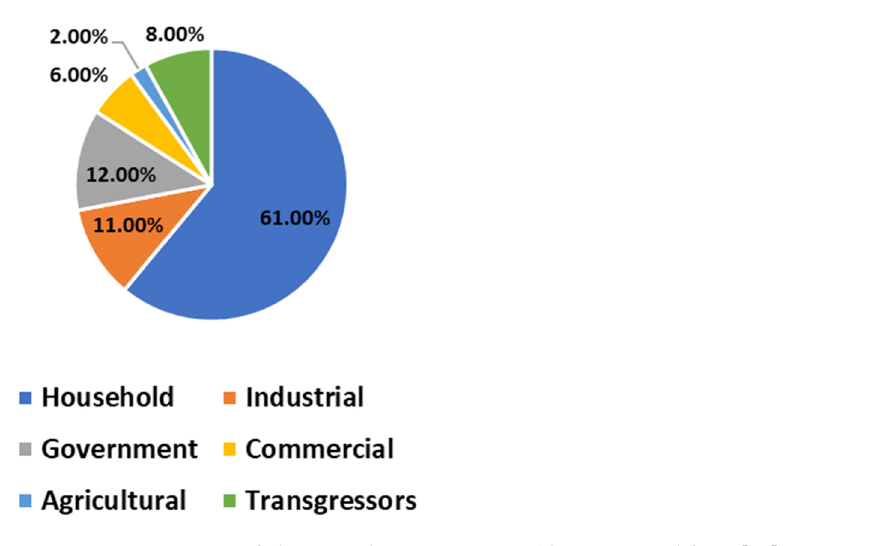
Figure 2. Consumption of electricity by sector in Iraq (data extracted from [28]). Table 1. Summary of electricity tariffs in Iraq in 2018 [39].